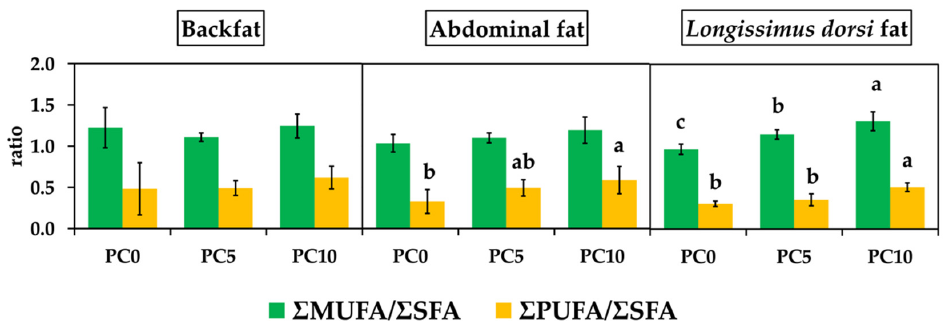
Figure 1. Effect of dietary perilla cake supplementation on the ratio of fatty acids in backfat, abdominal fat, and longissimus dorsi muscle. Superscription ( a , b and c ) indicates a significant difference between groups in Σ MUFA/ Σ SFA and Σ PUFA/ Σ SFA ratio ( p < 0.05). PC0, control; PC5, 5% perilla cake supplementation; PC10, 10% perilla cake supplementation.